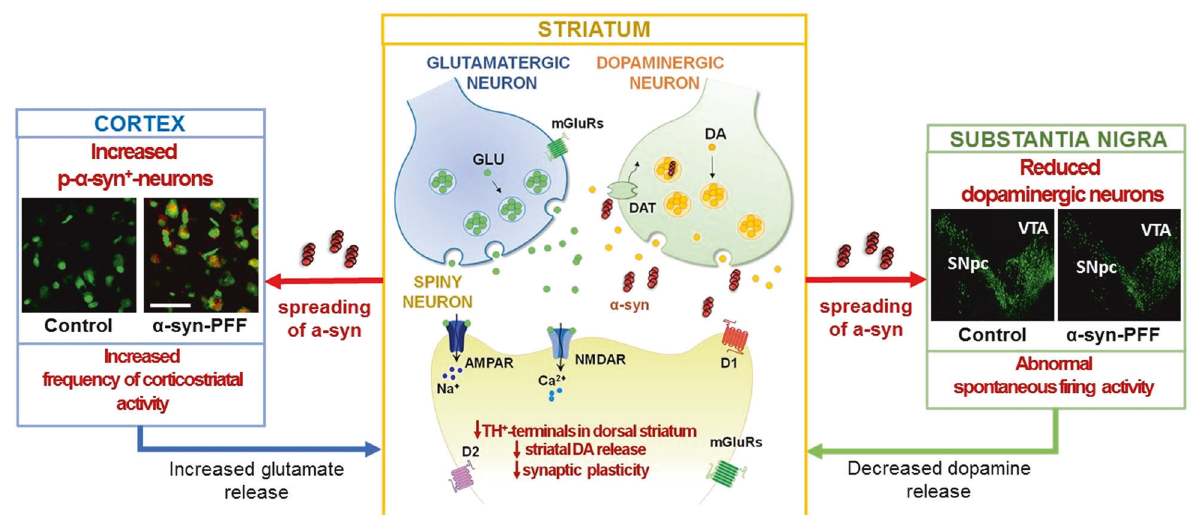
Fig. 3 Presynaptic and postsynaptic dysfunctions induced by intrastriatal injection of α -syn-PFFs in the rat model. Left panel: in the cortical areas, a consistent proportion of p- α -syn + neurons was detected in α -syn-PFFs-injected rats. Analysis of spontaneous synaptic currents indicates an increased frequency of the spontaneous excitatory postsynaptic current in target neurons of the dorsal striatum that brings to a state of hyperglutamatergic activity. Right panel: the SNpc in α -syn-PFF rats presents a reduced number of dopaminergic neurons as displayed by a decrease of TH + -immuno fl uorence, associated with an abnormal increase in spontaneous fi ring activity. Center panel: in the dorsolateral striatum, α -syn-PFFs injection leads to profound alterations of the corticostriatal long-term plasticity, in the SPNs. A signi fi cant decrease of TH + fi bers and a reduced release of endogenous dopamine from SNpc terminals are also